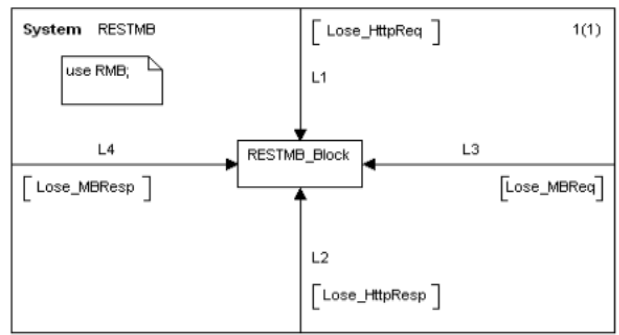
Figure 3: RESTMB system